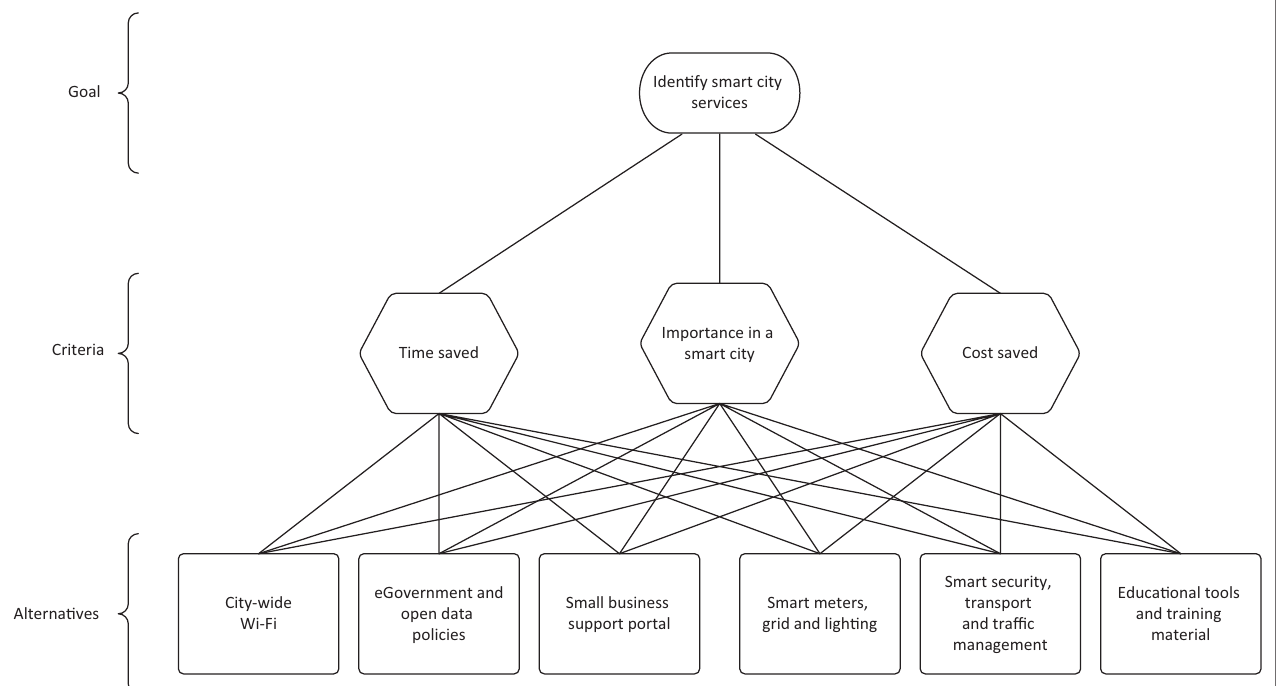
FIGURE 4: Analytical hierarchy process diagram of smart city